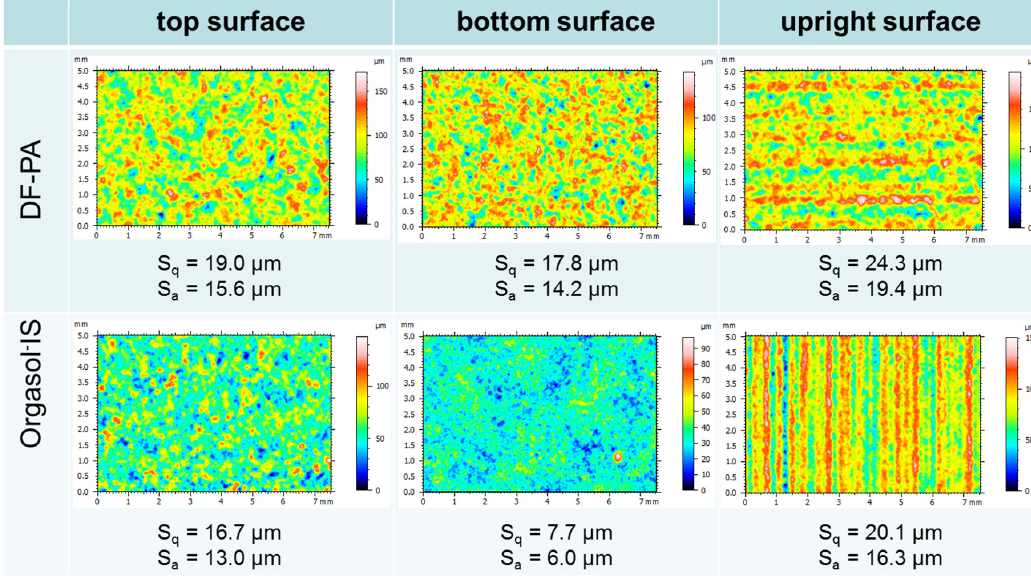
Figure 10. Comparison of surfaces from different part orientations of DF ‐ PA and Orgasol ‐ IS.